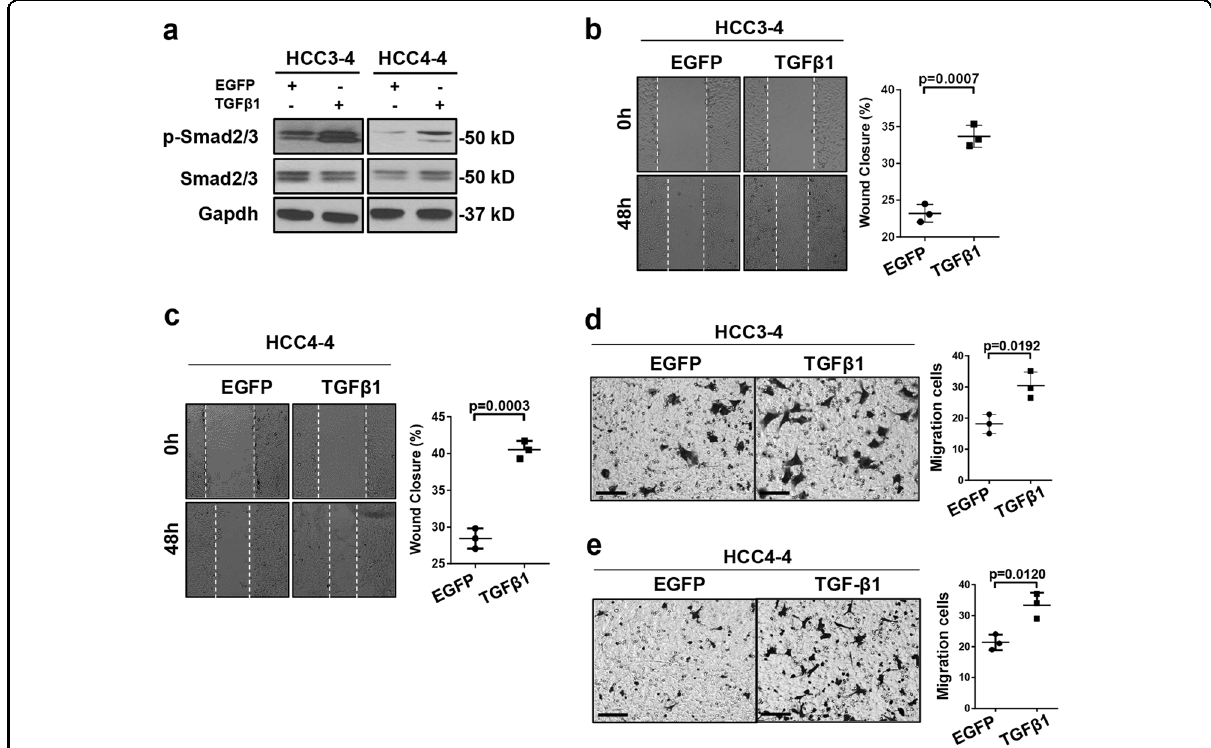
Fig. 4 TGF β 1 activation promotes cell migration and invasion in c-Myc murine tumor derived HCC cell lines. a Western blotting results showing activation of Smad2/3 (p-Smad2/3) in TGF β 1 overexpressing HCC3-4 and HCC4-4 cells. Gapdh was used as a loading control. b , c Representative images and quanti fi cations of cell healing assay at 0-hour (0 h) and after 48 hours (48 h) treatment for inducing TGF β 1 ( N = 3) or EGFP ( N = 3) expression in b HCC3-4 and c HCC4-4 cell lines. d, e Representative images and quanti fi cation of transwell migration assay 48 h after treatment for inducing TGF β 1 ( N = 3) or EGFP ( N = 3) expression in (d) HCC3-4 and (e) HCC4-4 cell lines. Student t test was applied for statistical analysis. P values were as shown. Experiments were conducted three